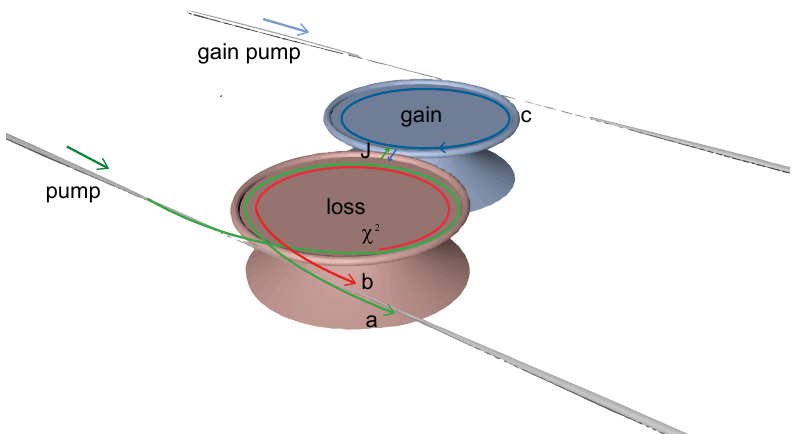
Figure 1. Schematic of a dimer with two active-passive micro-resonators to enhance the OPOs process. An optical passive (loss) micro-resonator with the second-order non-linearity χ ( 2 ) (the red one), which has an input pump mode (frequency ω a ) and a signal mode (frequency ω b (cid:39) ω a /2) generated by the pump laser through the optical parametric oscillation process. Meanwhile, the pump laser in the passive micro-resonator is coupled into the active micro-resonator (the blue one) with coupling strength J . The pump laser ( ω p (cid:39) ω a ) drives the passive micro-resonator through the two fiber